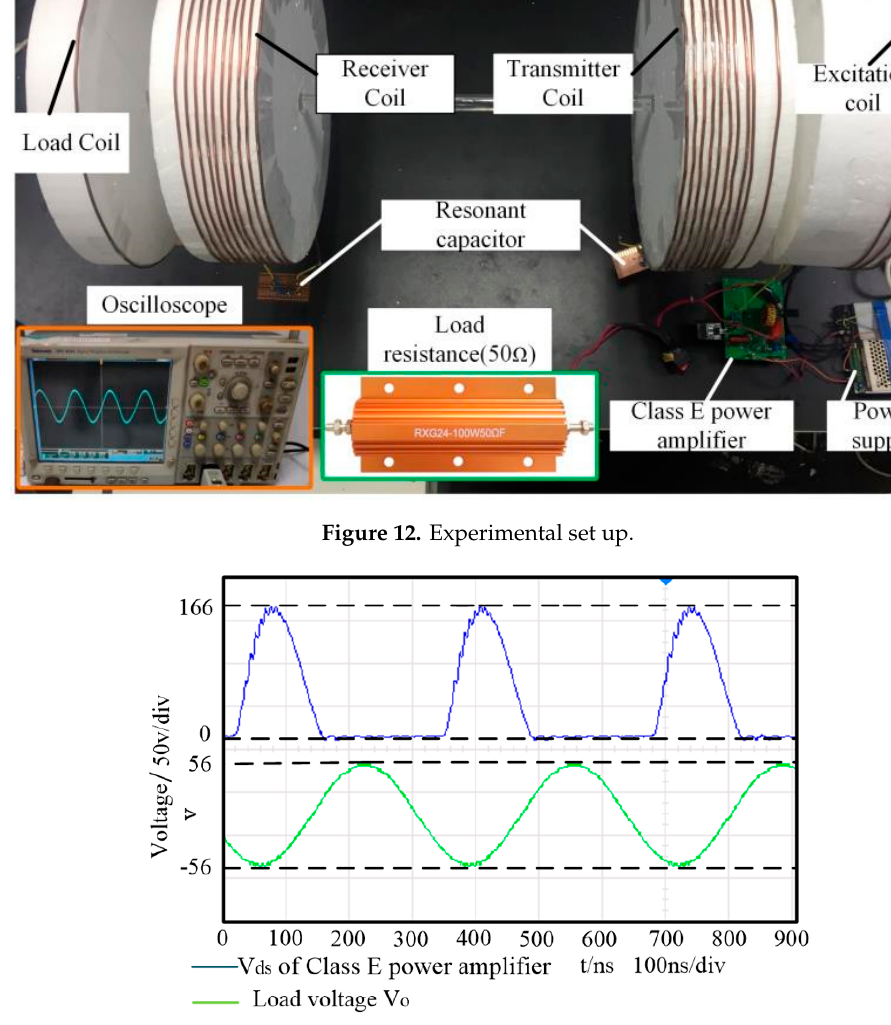
Figure 13. V ds and load voltage in optimal operating state.